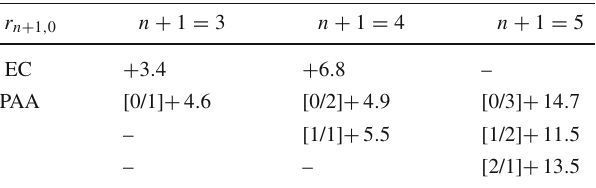
Table 2 Comparison of the exact (“EC”) ( n + 1 ) th-order conformal coefficients with the predicted (“ [ N / M ] -type PAA”) ( n + 1 ) th -order ones based on the known n th-order approximate ˜ R n ( M τ ) , where n =